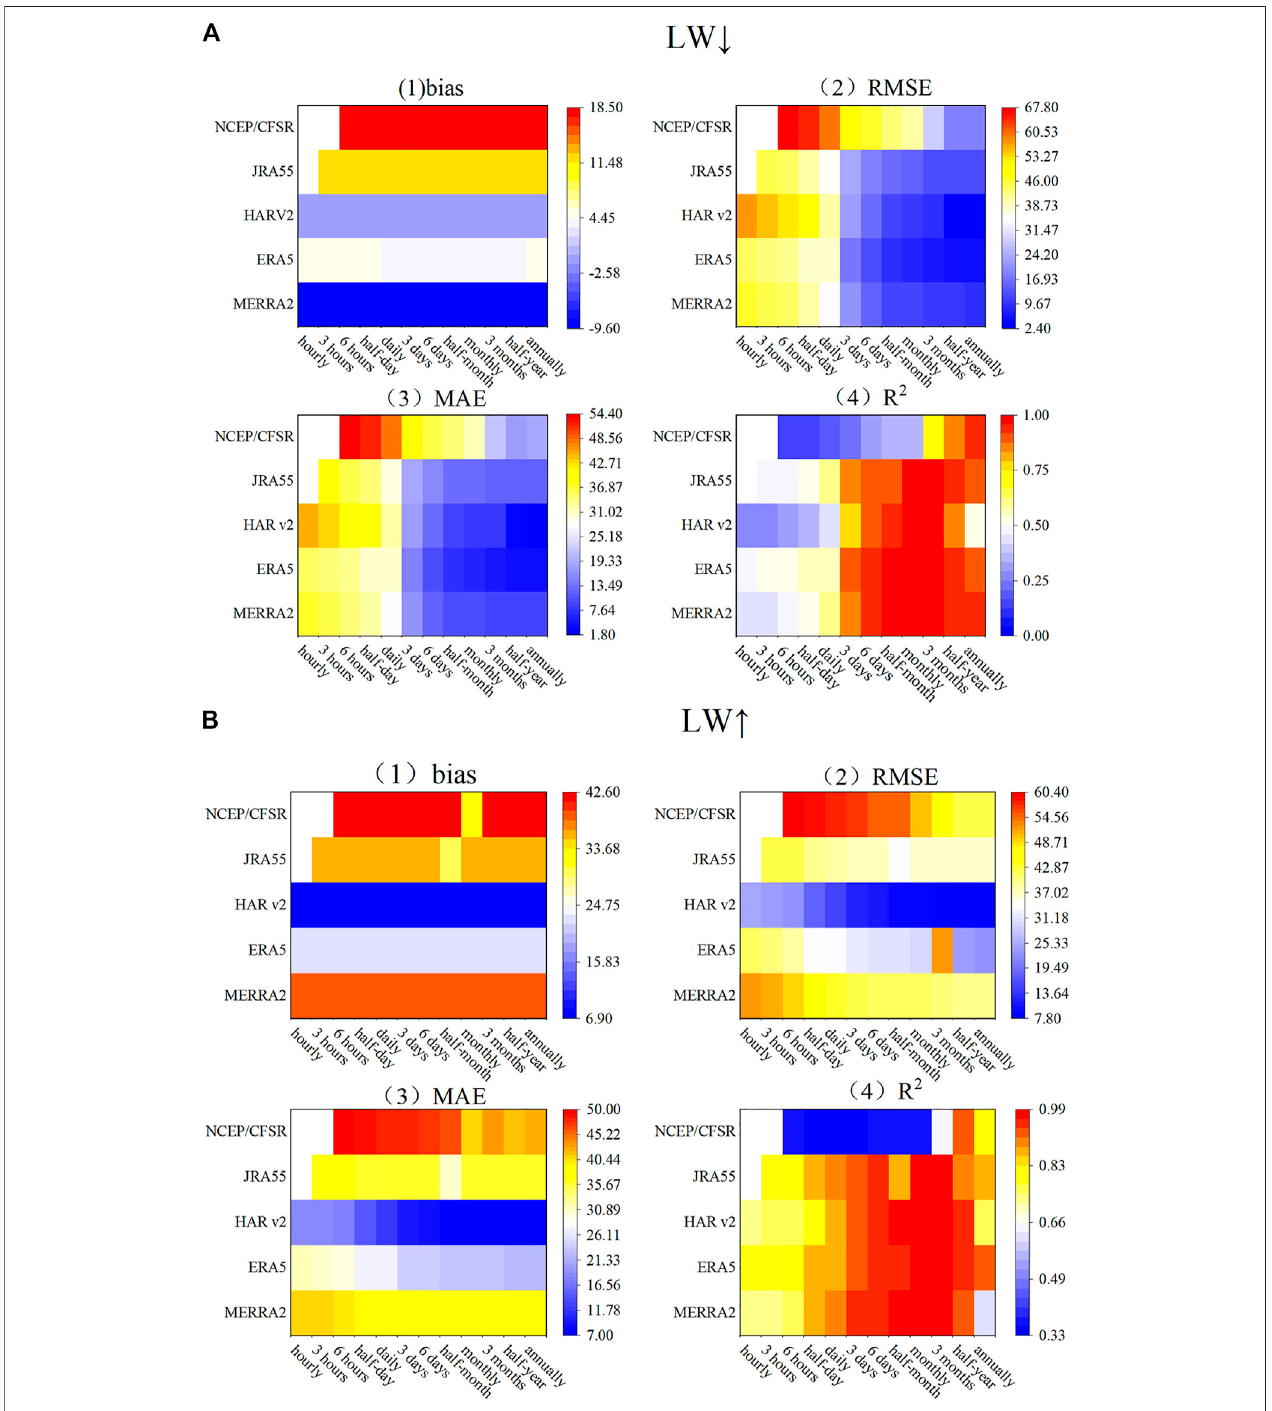
FIGURE 6 | Five sets of reanalysis datasets longwave radiation evaluation results; (A) and (B) represent downward longwave radiation and upward longwave radiation, respectively.